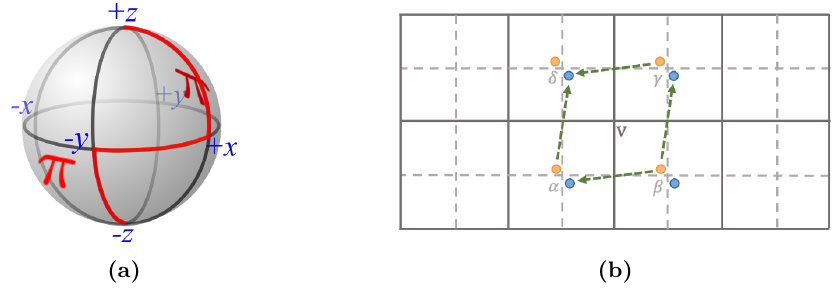
Figure 5. (a) (Reproduced from [29].) In the Lagrangian formalism, the worldline of the fermion may travel in ± ˆ x , ± ˆ y and ± ˆ t ( ± ˆ z ) directions, indicated by the 6 discrete points on the “Bloch sphere”. The 12 arcs connecting these points correspond to the 24 ways that the worldline may make a turn. The 3 red arcs correspond to the 6 ways of turning that will contribute a ( − 1) factor to the partition function, while the remaining 9 black arcs are 18 ways of turning that will contribute a (+1) factor. We may interpret the ( ± 1) factor as the exponentiation of the integration of a Berry connection along the arc. Thus, there is a π Berry phase around the 1/8 sphere cornered at (+ x, + y, + z ) and the 1/8 sphere cornered at ( − x, − y, − z ) . (b) The Γ operator defined in the Hamiltonian formalism produces the same Berry phase. Here we also illustrate the positions of the dual vertices α, β, γ, δ used in (A.13) and